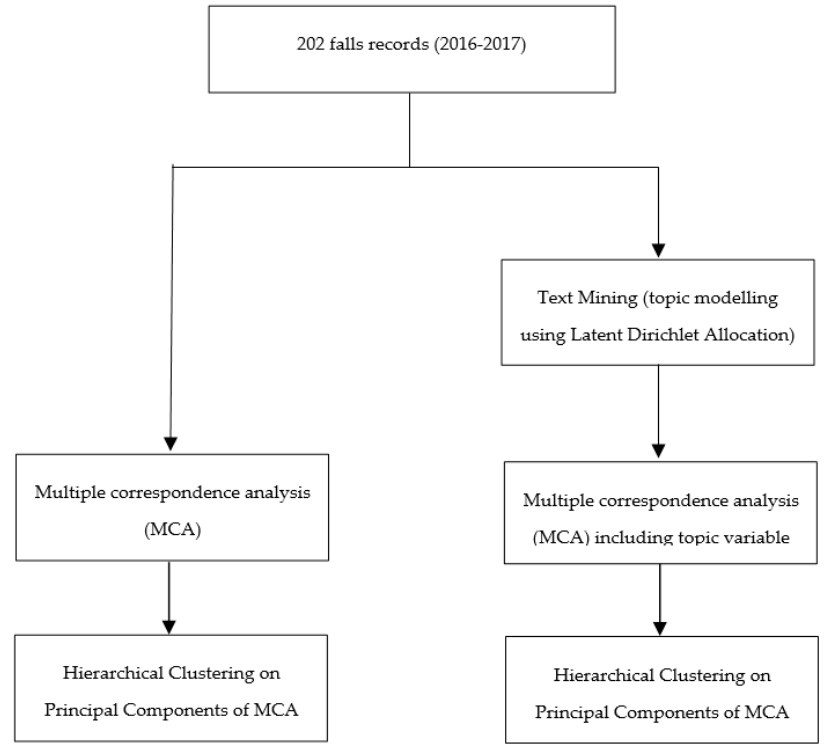
Figure 1. Flow-chart presenting the summary of the study procedures.